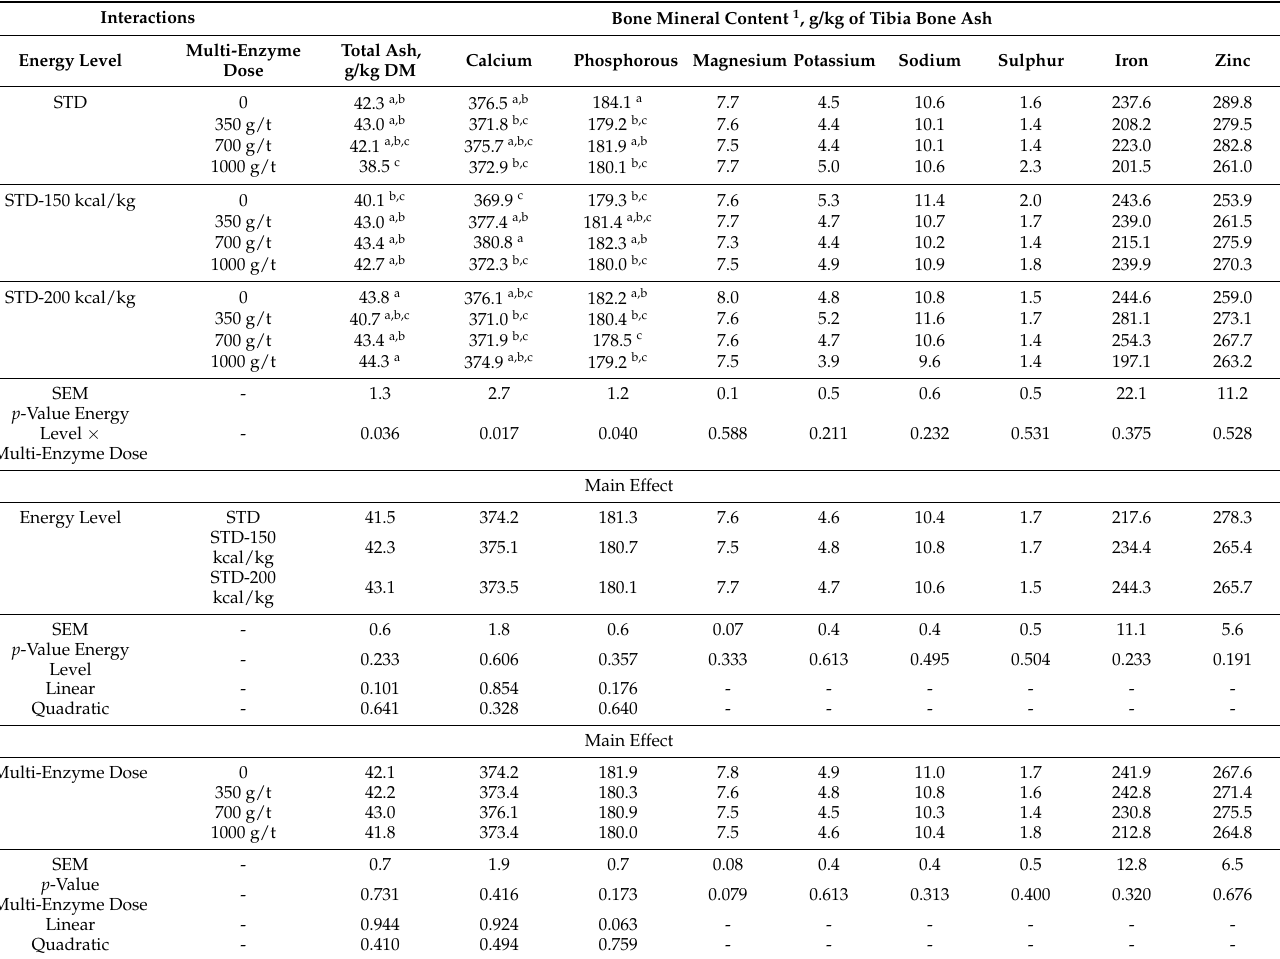
Table 7. Effects of multi-enzyme super-dosing in reduced energy diets on bone mineral content of broiler chicken.